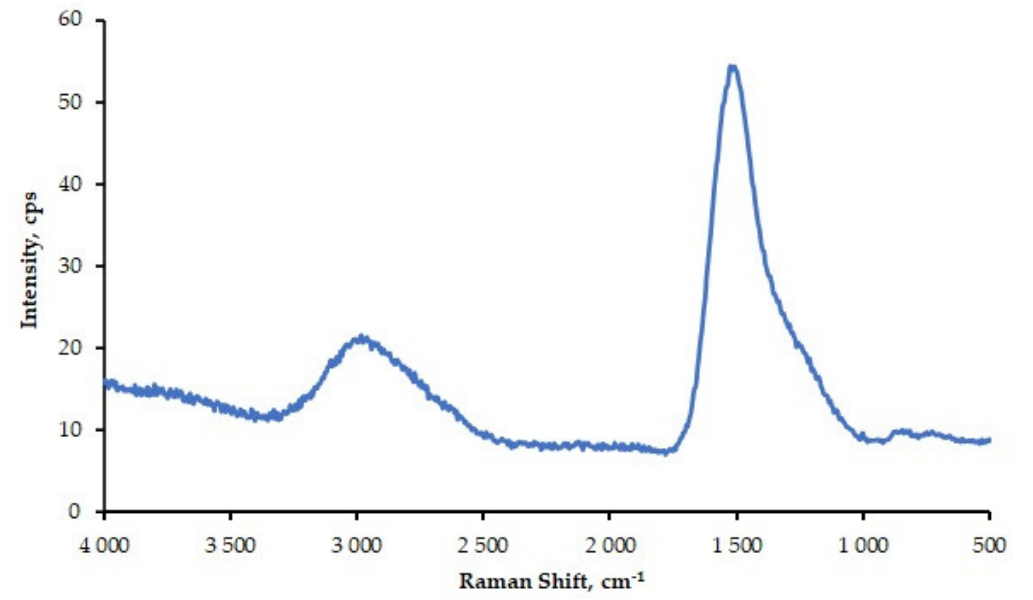
Figure 2. The Raman spectra of the diamond-like coating (DLC) coating.